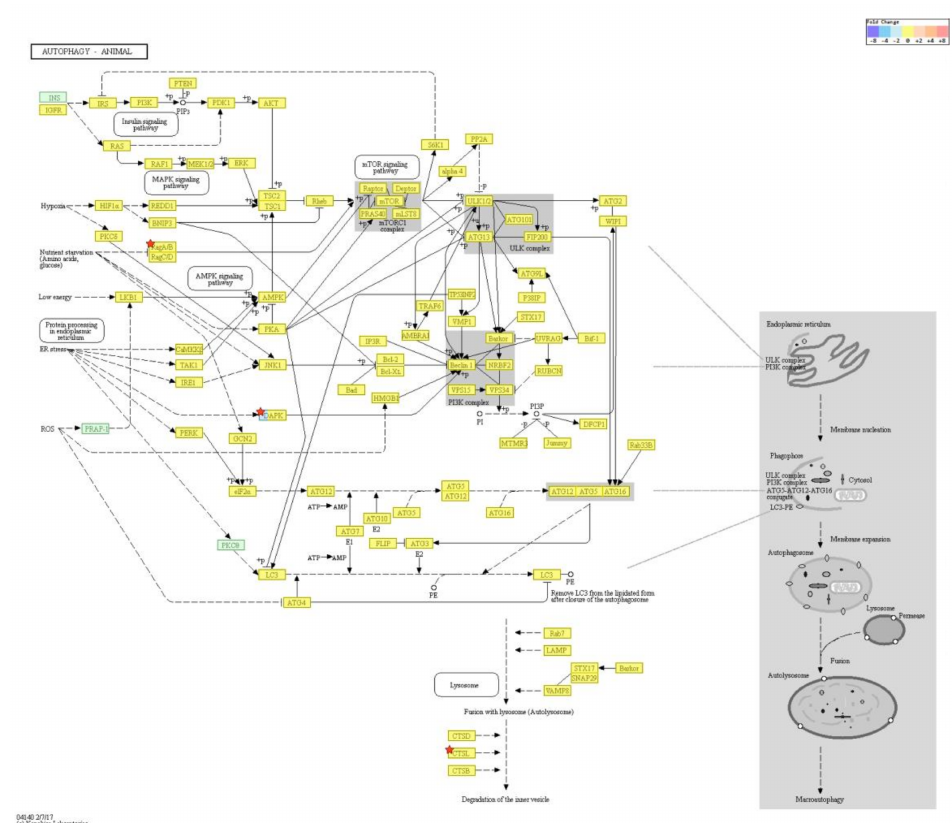
Figure 4. KEGG pathway analysis on autophagy. Among the autophagy-related genes, CTSL was. upregulated, and DAPK1, RRAGB, DAPK2 downregulated in PM exposed cells ( p < 0.05). Pathway analysis for significant gene list were performed based on KEGG pathway (http://www.genome.jp/ kegg/pathway.html) (accessed on 19 July 2018).